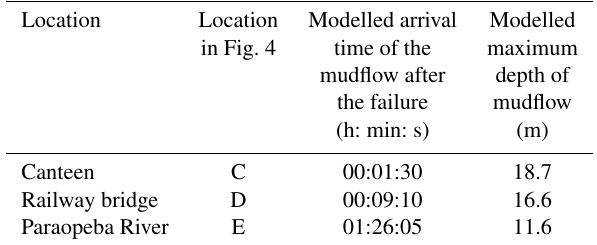
Table 2. Modelled mudflow depths and arrival times at key loca-